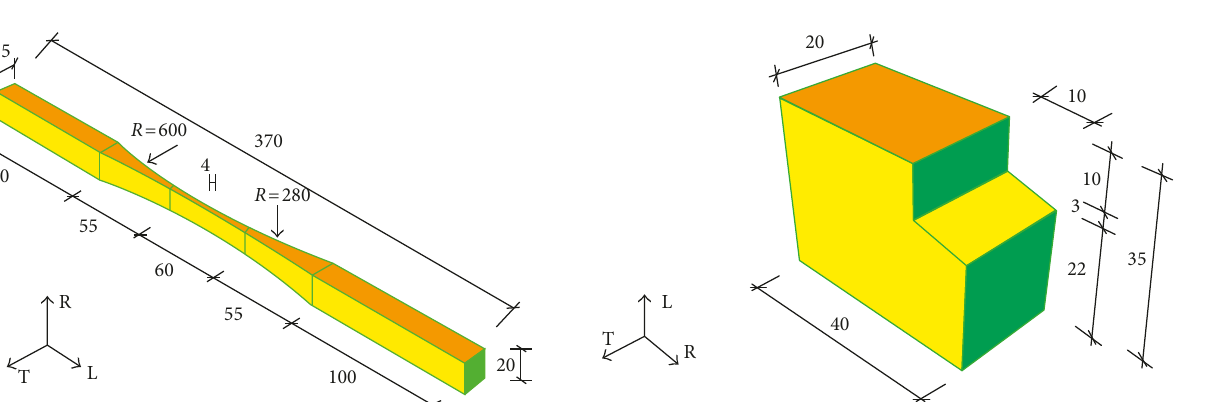
Figure 3: Details of specimens for tensile strength parallel to grain of wood (unit: mm).